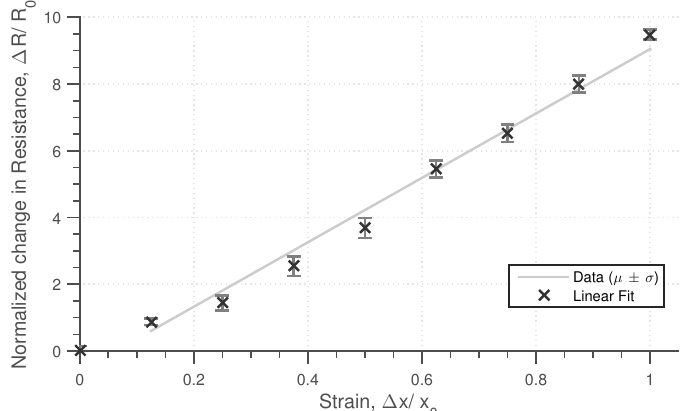
Figure 3. Plot of force against normal strain for the soft conductive silicon sensor showing the mean and standard deviation. Strain was applied in steps of 10%, with this cycle repeated 5 times with the average and standard deviation determined.